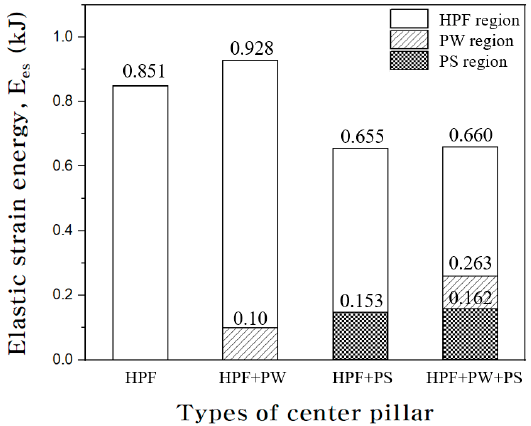
Figure 13. Maximum elastic strain energy ( E es ) of the four types of center pillar.